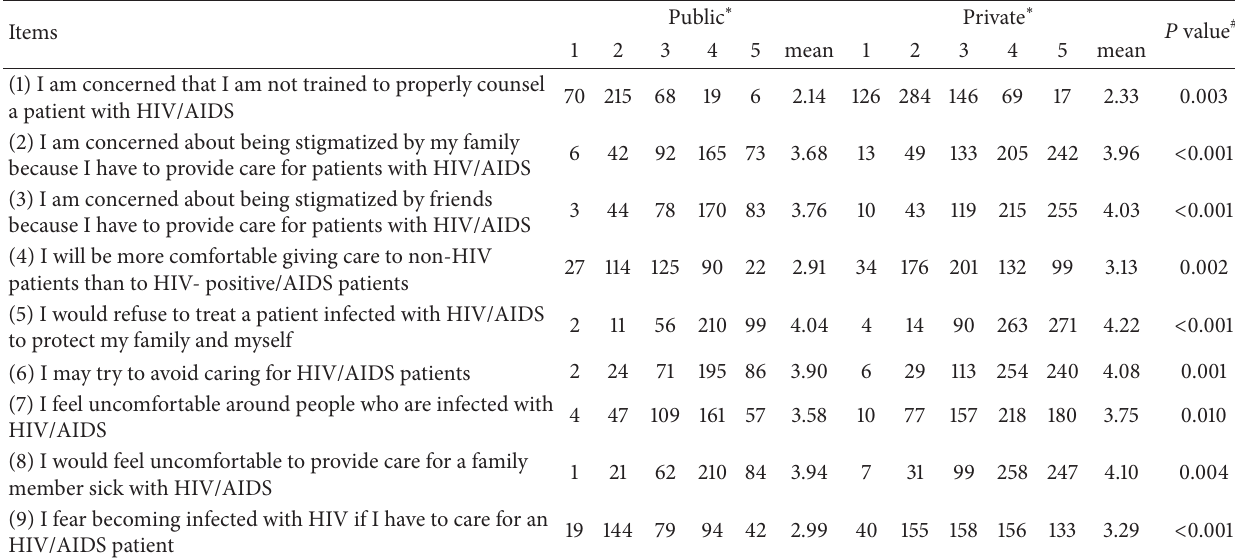
Table 4: Public and private medical students’ attitudes towards giving care to individuals with